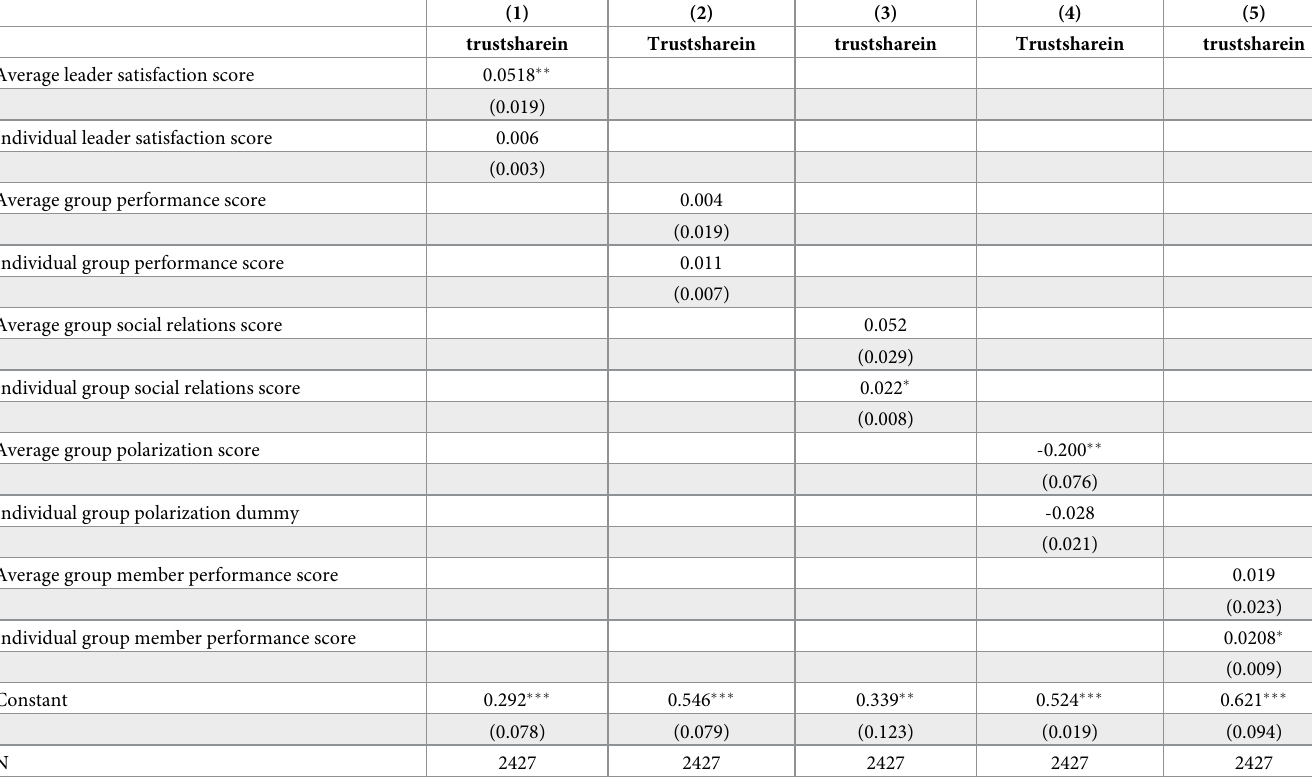
Table 9. Correlations between ingroup trust and five other group performance